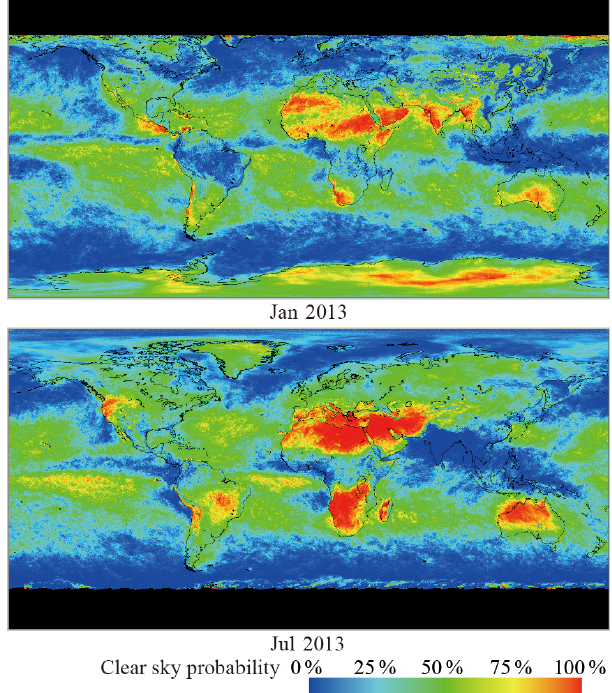
Figure 2. Clear-sky probability at 0.1 ◦ × 0.1 ◦ calculated with MYD35_L2. There are low clear-sky probabilities over most tropi- cal rainforests because the moisture helps to create clouds.